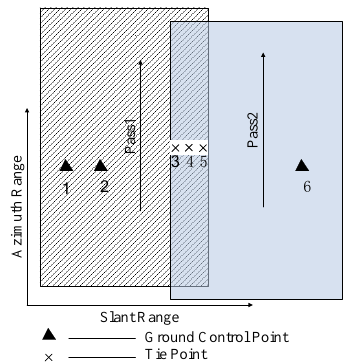
Fig.6 Needed GCPs for Two Passes with Block Adjustment Both GCPs and Tie Points(TPs) in the two passes can be used. For GCPs, the unwrapped phases and the heights are known. While for TPs, only the unwrapped phases are known, but TPs different blocks (or passes) are deemed as equal.